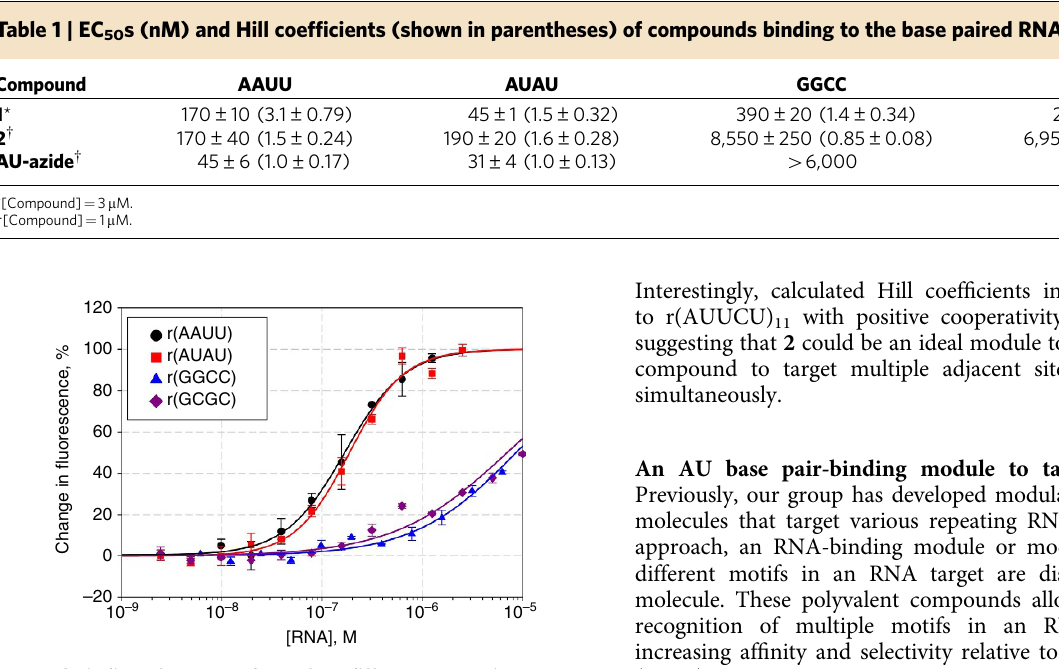
Figure 3 | Binding of compound 2 to four different RNAs Fluorescence binding assays of compound 2 to RNAs with different base pairs show that 2 binds AU base pairs selectively over GC base pairs by 4